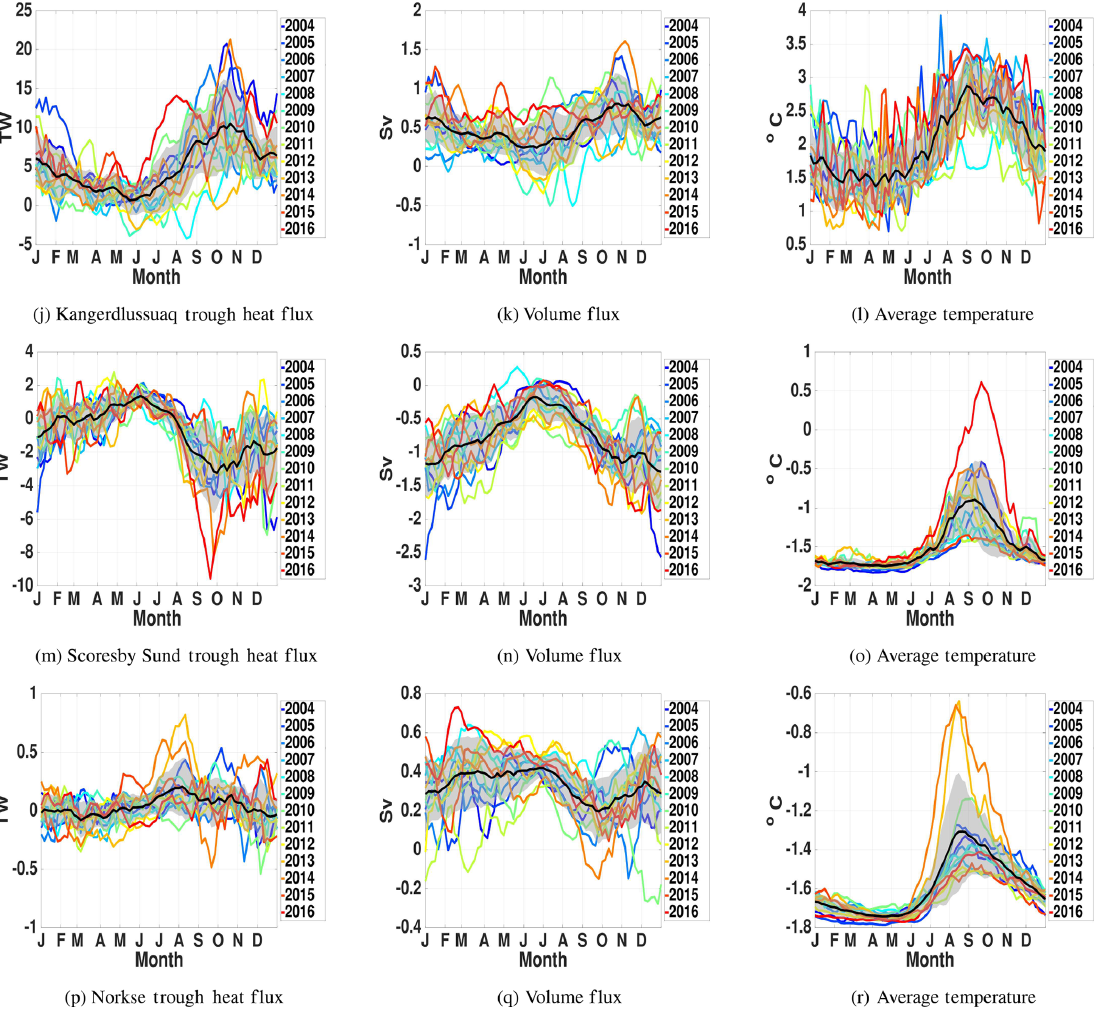
Figure 10. Seasonality of the heat flux (unit: TW; 1TW = 10 12 W), volume flux (unit: Sv; 1Sv = 10 6 m 3 s − 1 ) and section-averaged temper- ature (unit: ◦ C) in MVBCT, DBT, KT, SBST, and NT (locations shown in Fig. 1) for each year from 2004 to 2016 (colour codes are shown in the legend). Note that the black line shows the mean of the 25d moving-window averages (Eq. 3) over 2004 to 2016, with the standard deviation shown by the grey